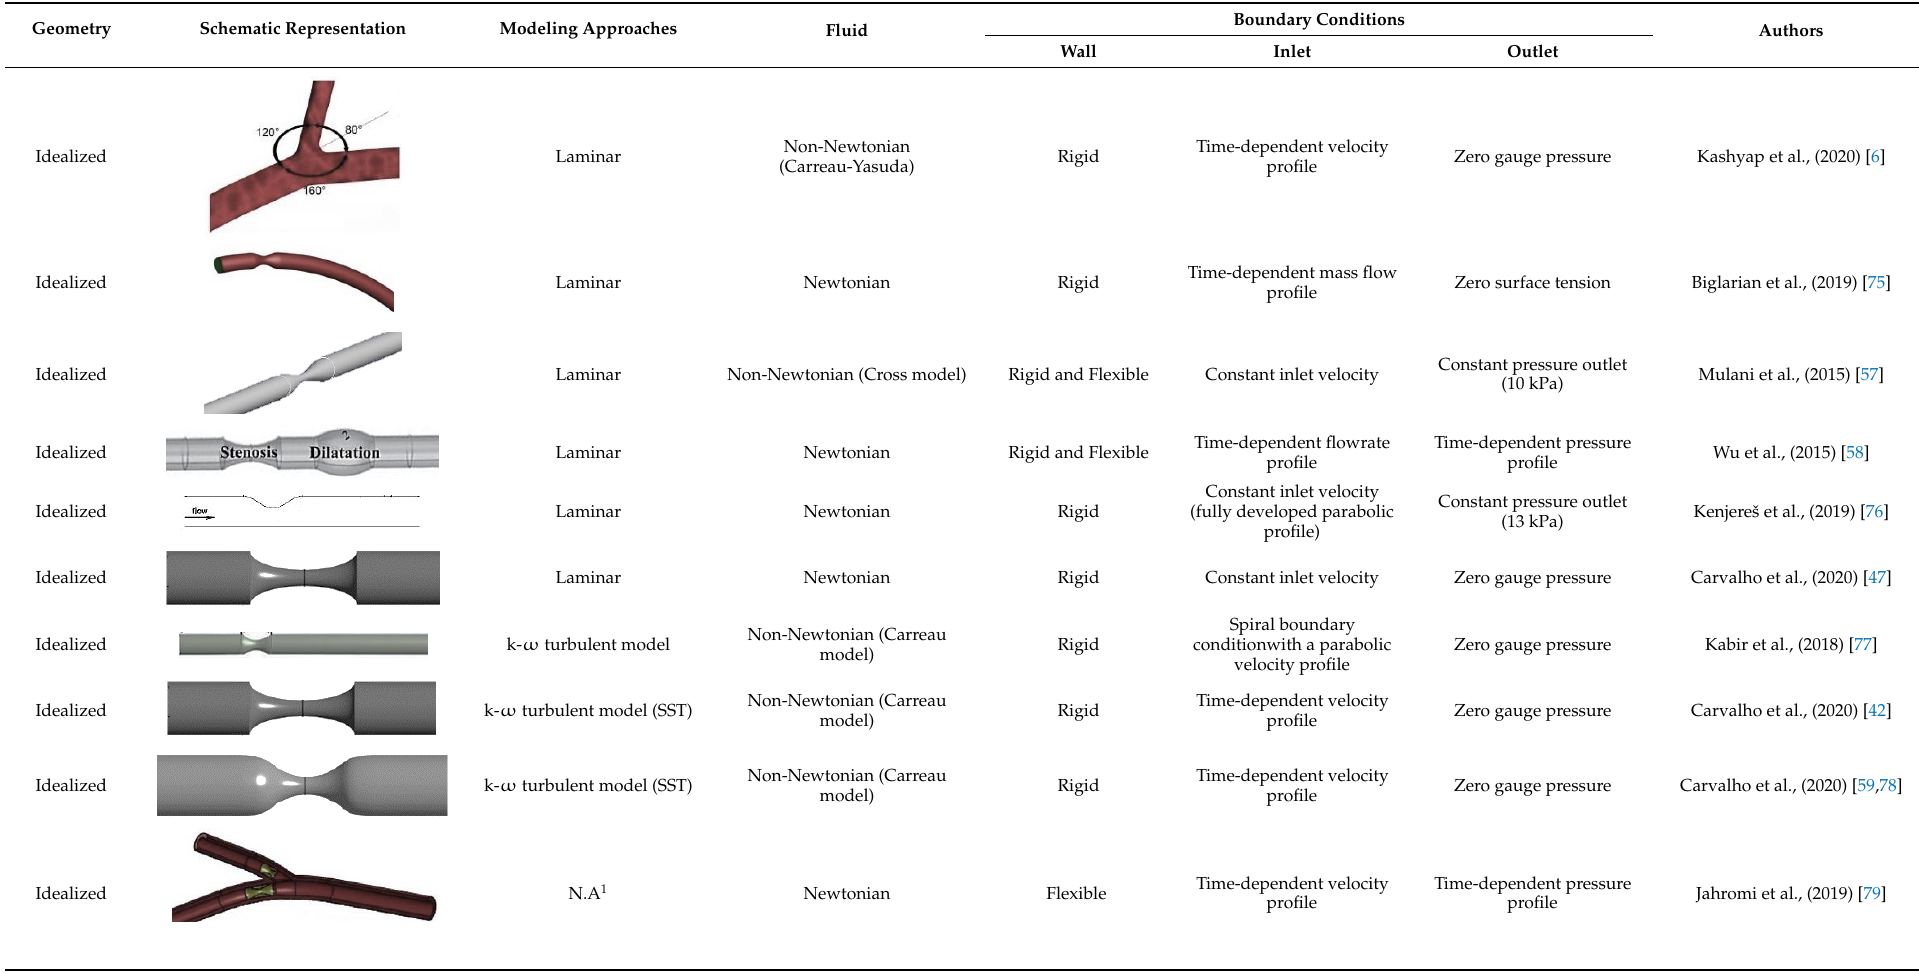
Table 1. Numerical studies of hemodynamics and the respective assumptions for numerical simulations.